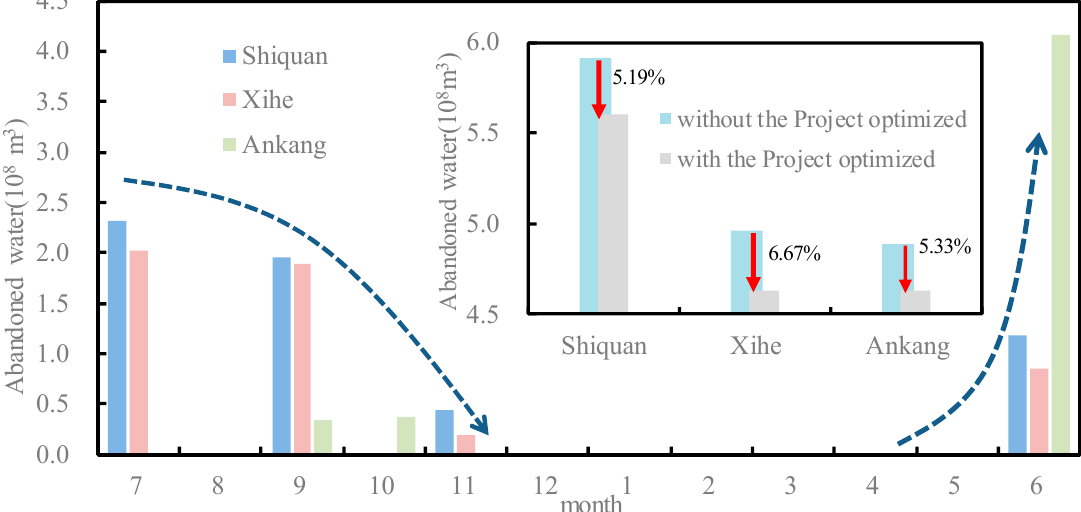
Figure 7. The monthly average change process of water abandoned of the Shiquan, Xihe, and Ankang reservoirs in condition of the Project optimized. The upper right part is the multi-year average change of abandoned water when the operation of Project is optimized or